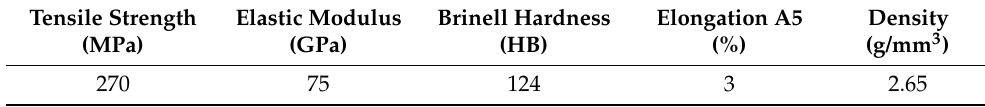
Table 2. Material properties of the selected SLM additively manufactured AlSi10Mg alloy.